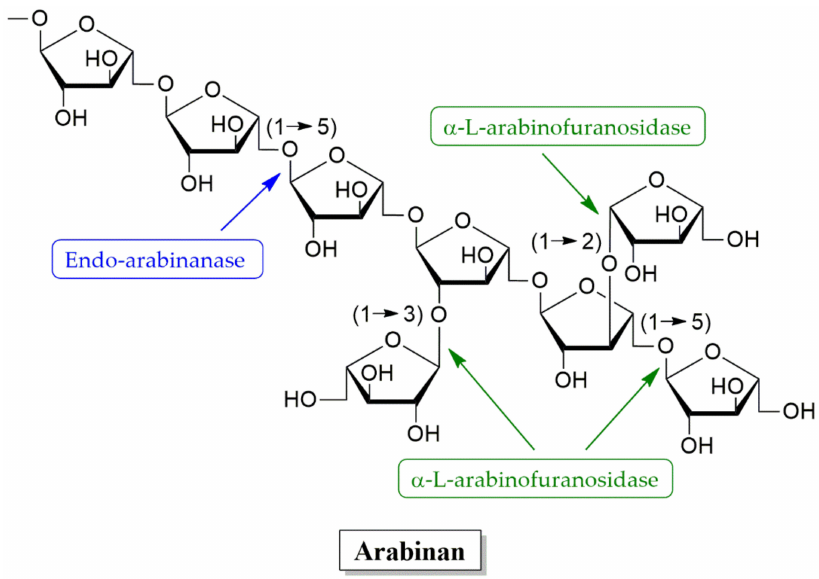
Figure 8. Enzymes involved in arabinan